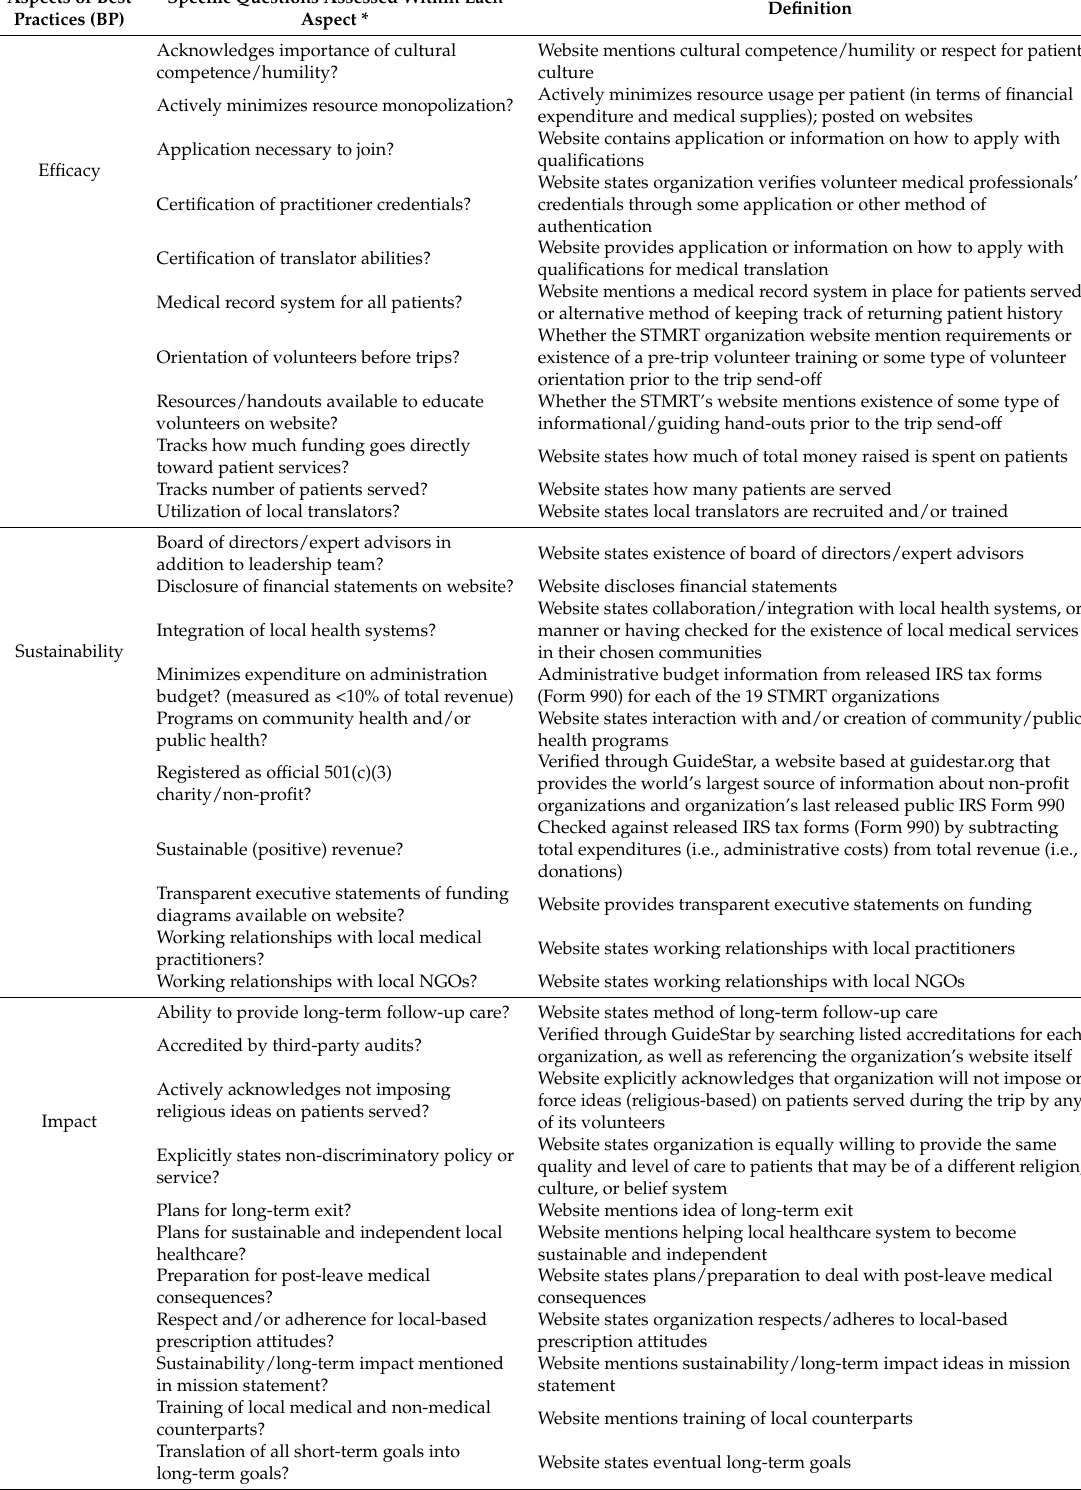
Table A1. Definition for Y/N Questions Assessing BP in Table